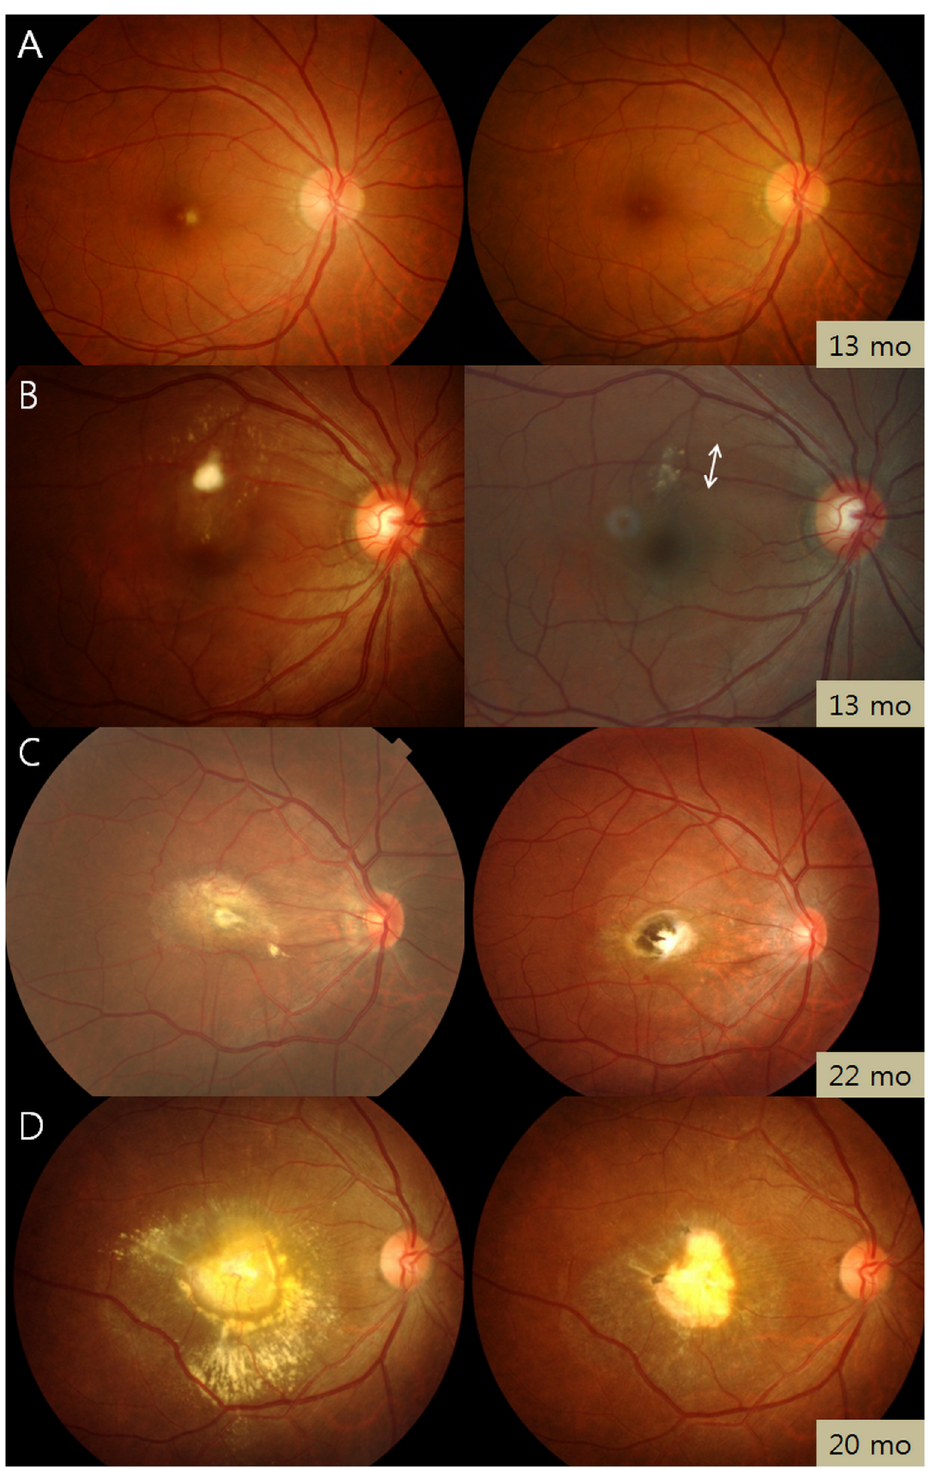
Figure 4. Clinical course of granuloma in ocular toxocariasis. Fundus photographs taken at diagnosis (left column) and the last visit (right column) show several patterns. Complete resolution (A), partial resolution (B), partial resolution of retinal infiltrate with pigmented scar (C), and the remains of an inactive granuloma (D). Each photograph is labeled with the follow-up time in months (mo). Double arrow in B denotes retinal nerve fiber layer defect.